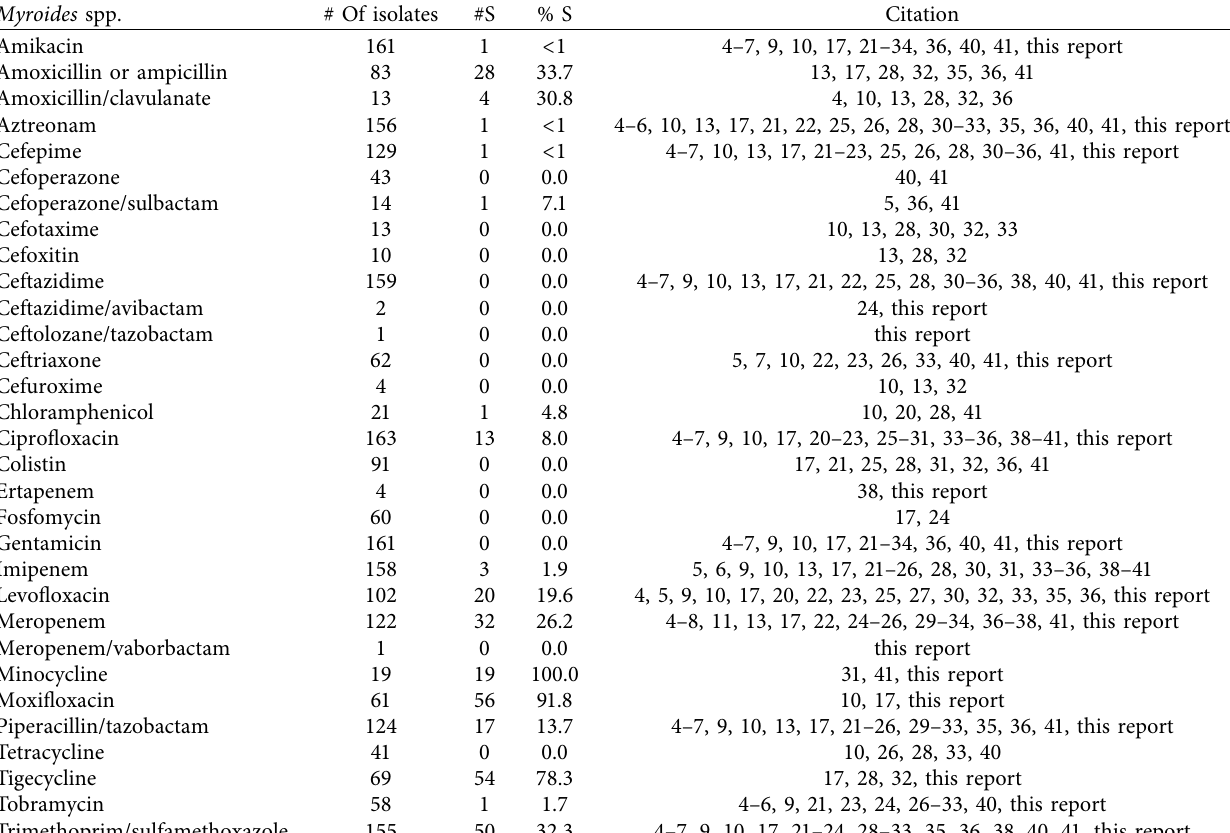
Table 2: Review of published antimicrobial susceptibility results for Myroides spp. Myroides